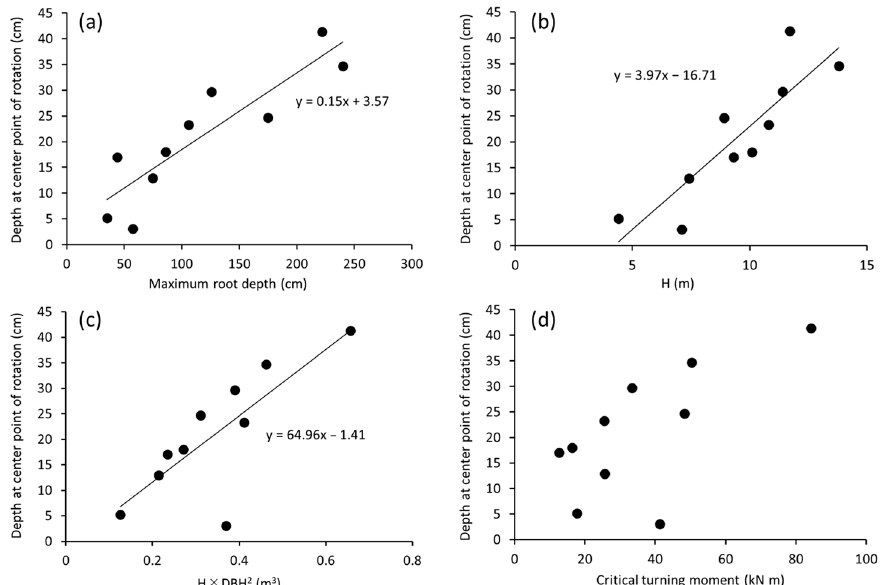
Figure 4. Relationships between ( a ) depth at the center point of rotation (Dcp) and maximum root depth, ( b ) Dcp and H, ( c ) Dcp and H × DBH 2 , and ( d ) Dcp and critical turning moment.